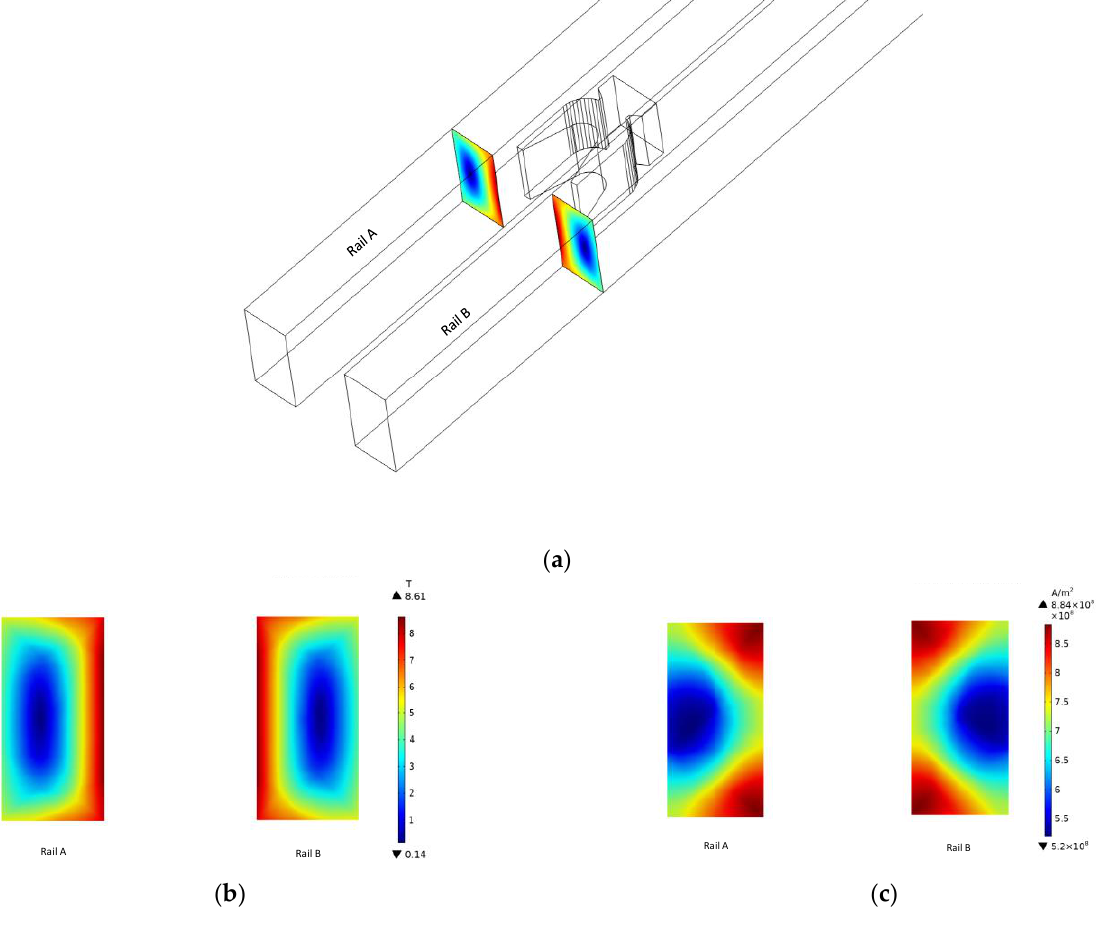
Figure 4. The numerical simulation results of the electromagnetic field on rail section at 1.2 ms. ( a ) Observation angle. ( b ) Magnetic flux density on rail section. ( c ) Current density on rail section. The numerical simulation results of the electromagnetic field on the armature horizon- tal cross-section at 1.2 ms are shown in Figure 5. The horizontal cross-section in the middle of the armature is selected as the observation angle. The magnetic flux density tends to be concentrated at the throat position inside the armature with a maximum value of 16.5